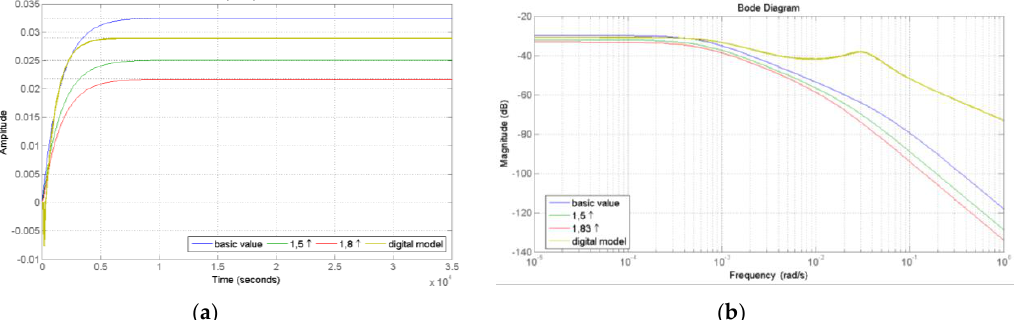
Figure 3. Segment G1 step ( a ) and frequency responses ( b ) for simulation of changes in thickness of absorber.